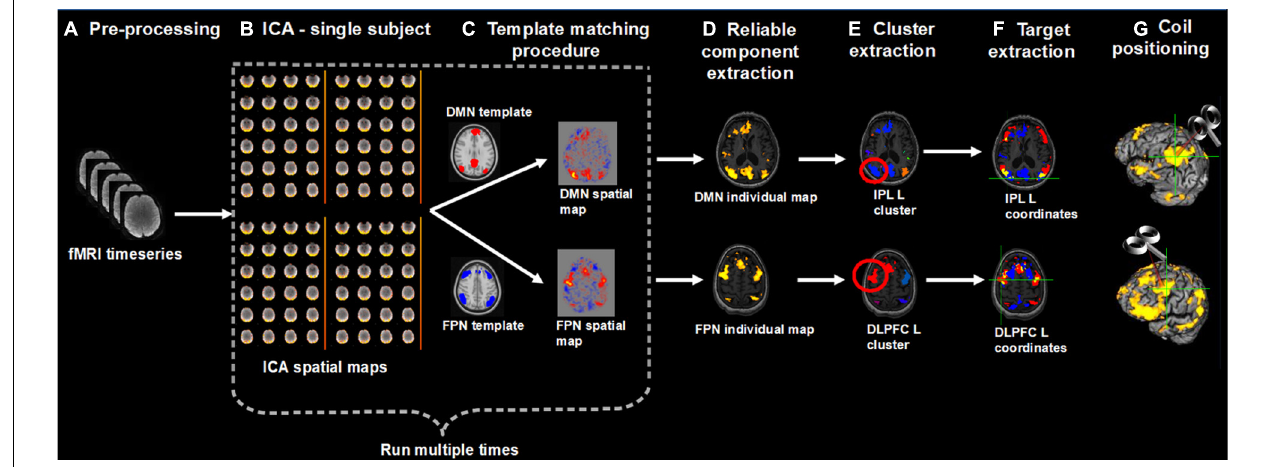
FIGURE 1 | Overview of the procedure for the identification and selection of individual DMN and FPN targets based on rs-fMRI; (A) Collected rs-fMRI data were pre-processed removing the first time-points, correcting motion, and susceptibility-induced distortions; (B) DMN and FPN were extracted from individual rs-fMRI scans using independent component analysis (ICA); (C) Networks of interest (in MNI space) were identified using a template matching procedure; (B,C) were repeated multiple times; (D) The most reliable components were identified and back-transformed to subjects’ native T1 space; (E) Each network was decomposed into clusters and the largest cluster in the left IPL and left DLPFC was identified, for the DMN and FPN, respectively; (F) The peaks (local maxima) within these clusters were extracted and the final individual TMS targets were selected according to the following criteria: (i) location specific to the network of interest, i.e., coordinates falling within the spatial maps of both DMN and FPN (yellow areas) were excluded (blue = DMN, red = FPN); (ii) being on a cortical gyrus and not on a sulcus (i.e., overlap with GM); (iii) representing the shortest perpendicular path between scalp and cortex; (G) TMS coil was positioned through a neuronavigation system to target the selected DMN and FPN